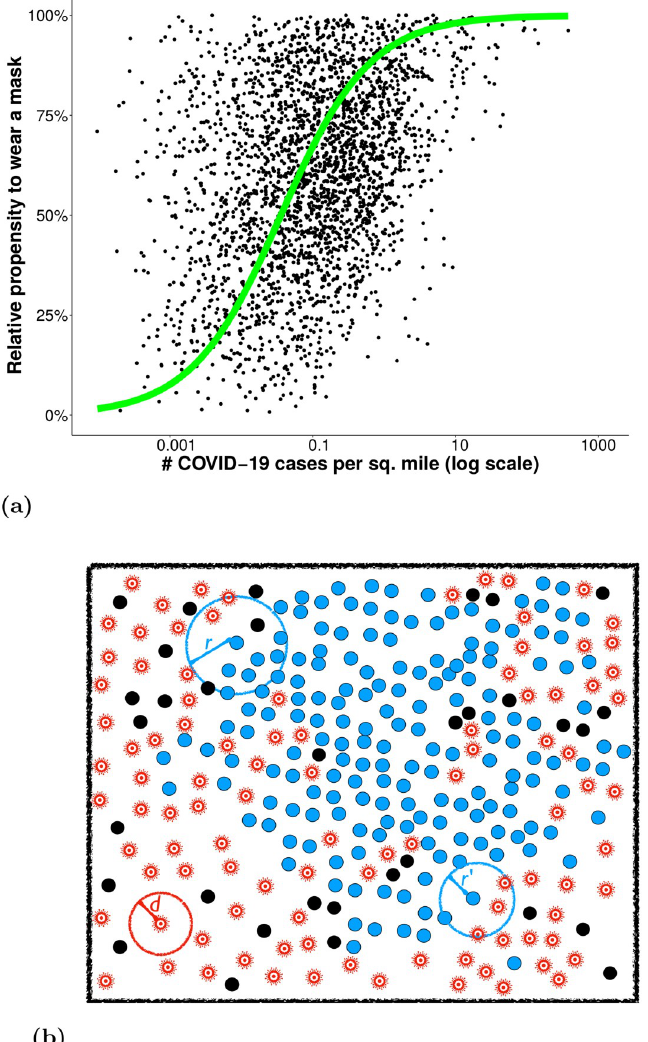
Fig 1. Model and its rationale. (a) Propensity of survey respondents in U.S. counties who ‘Always’ or ‘Frequently’ wear a mask in public during COVID-19 [52], versus confirmed infections per square mile. Data are from July 2020; each point represents a U.S. county. The green curve shows a sigmoid fit of y = (1+ exp[ − 1.6( x + 0.08)]) − 1 . The ‘propensity’ on the y-axis accounts for the limited range in the county-aggregated data: about three-quarters of U.S. counties have survey results between 40% and 90% who ‘always’ wear masks, such that ‘propensity to socially distance’ measures how far each county plots between these endpoints. (b) Illustration of the agent-based model. Uninfected agents who are social distancing are colored black and agent who are not are colored blue. The circle in the lower left shows radius of infection, d